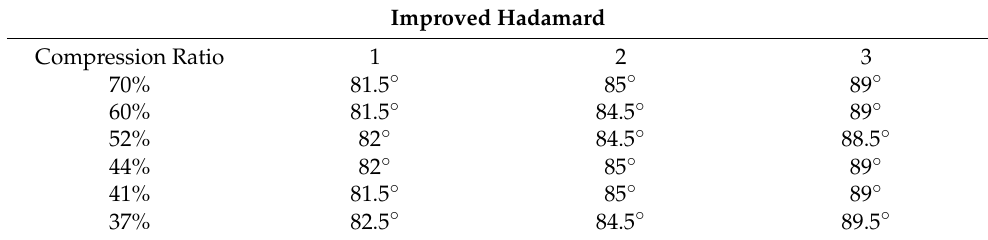
Table 5. The angle of a mark in different Compression